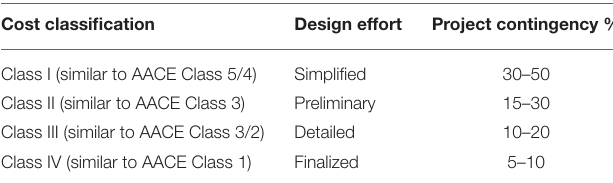
TABLE 4 | Guidelines for deriving project contingency (Electric Power Research Institute, 1993; AACE International, 2011; Rubin et al.,